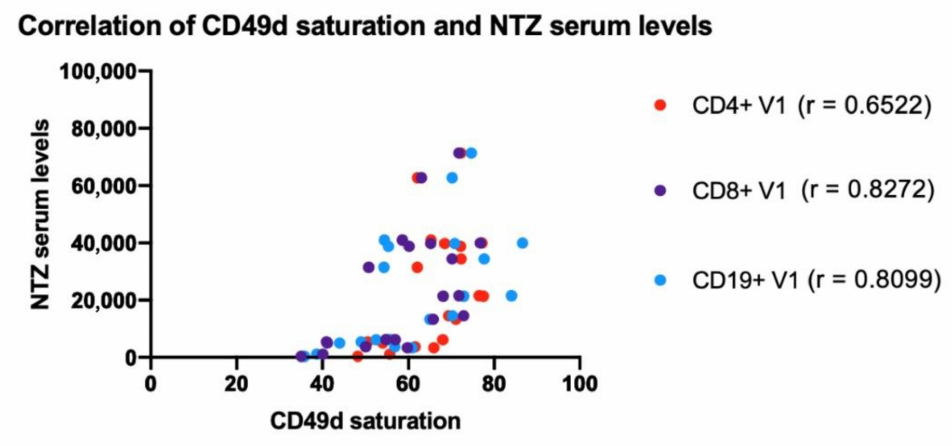
Figure 8. Correlation between Natalizumab serum levels ( µ g/mL) and CD49d saturation (%) in CD4 + and CD8 + T lymphocytes and CD19 + B lymphocytes in RRMS patients under Natalizumab treatment. Each dot represents a patient of the study ( n = 29). ns: p > 0.05. NTZ: